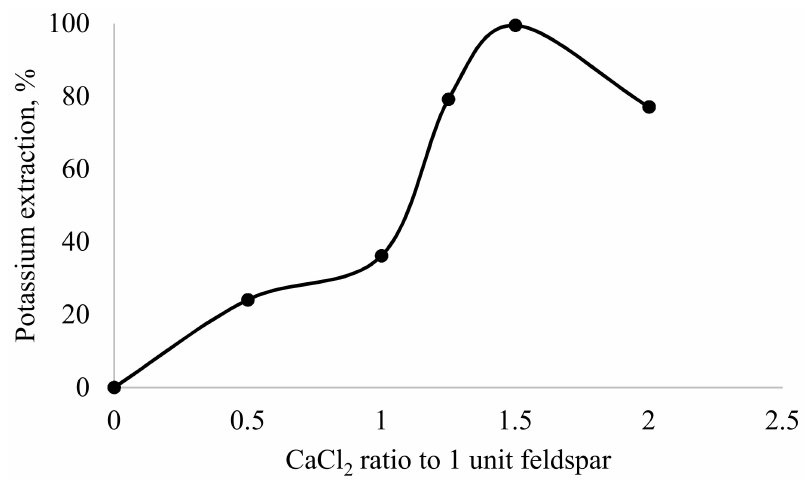
Figure 8. Effect of the CaCl 2 amount.